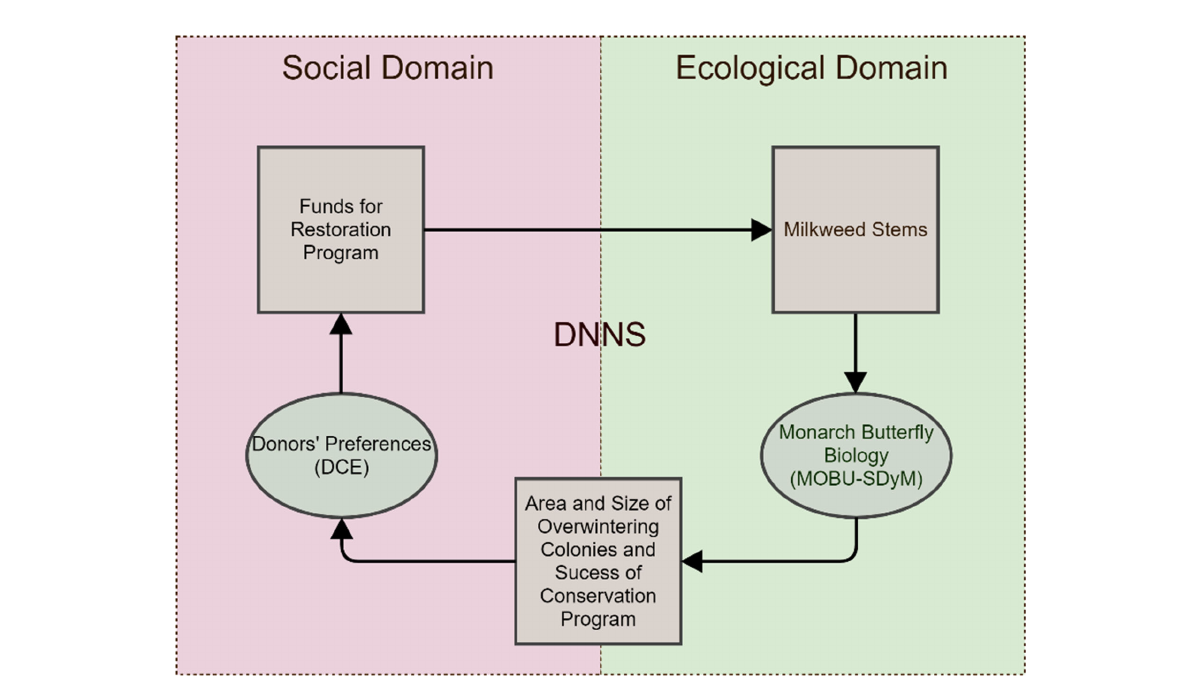
FIGURE 2 Model Overview. The Donor-NGO-Natural System of the Monarch (DNNS) is a dynamic system that emulates the Monarch ’ s habitat-dependent population dynamics (Ecological Domain). It assumes that such dynamics will affect the willingness to support a conservation program by potential donors (Social Domain), which, in turn, will affect the reach of the conservation program and success in subsequent iterations.